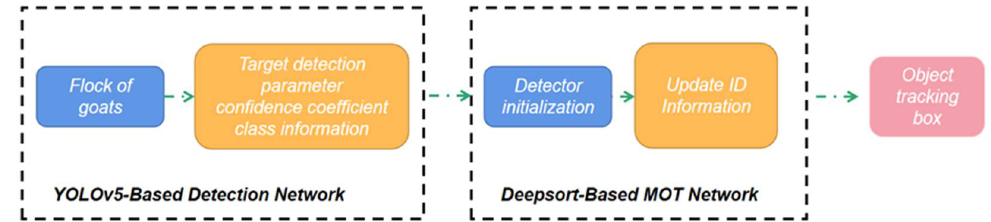
Figure 12. Changes in mAP@0.5 during training.